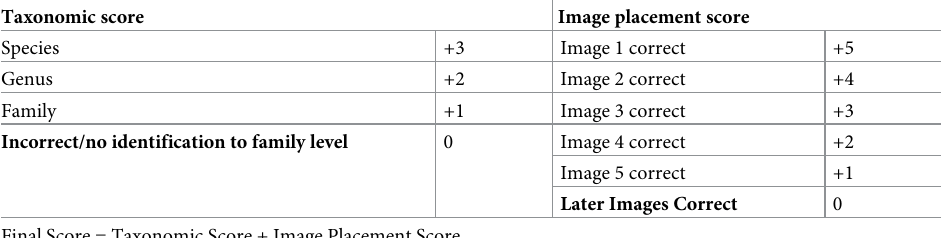
Table 2. Scoring system A. Scores were allocated to a plant organ image (leaf or flower) by combining the taxonomic score and the image placement score. Taxonomic